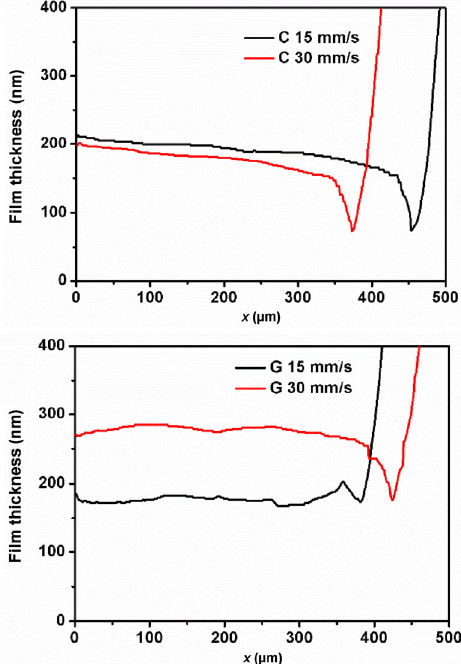
Fig. 14 Film thickness for aluminum complex-based and urea- based grease at different rolling speeds ( p max =0.58 GPa, straight line